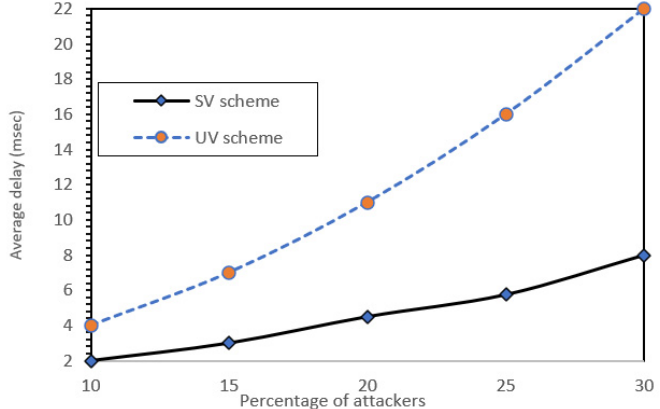
Figure 5. Comparison of the two schemes’ delay.